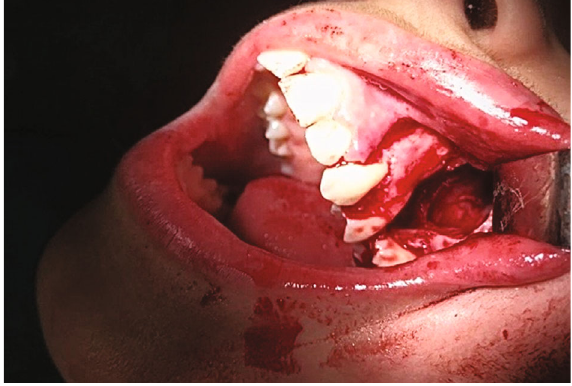
Figure 9: Immediately after the removal of ectopic premolar